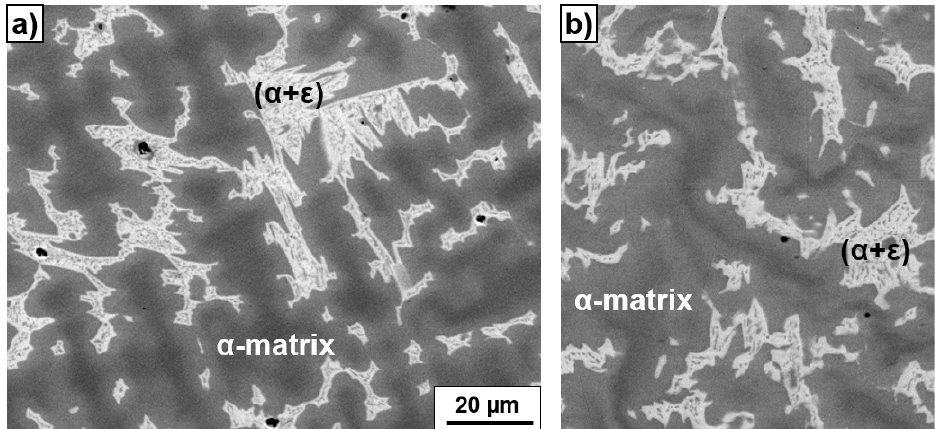
Figure 1. SEM images of the Cu–14 wt% Sn alloy after annealing at 320 °C for 1200 h ( a ) and following HPT deformation ( b ). The micrographs were obtained for the radius r = 3 mm. The strain for r = 3 mm and 5 plunger rotations was, respectively, γ = 270 and e eq = 156 (see also Section 2).